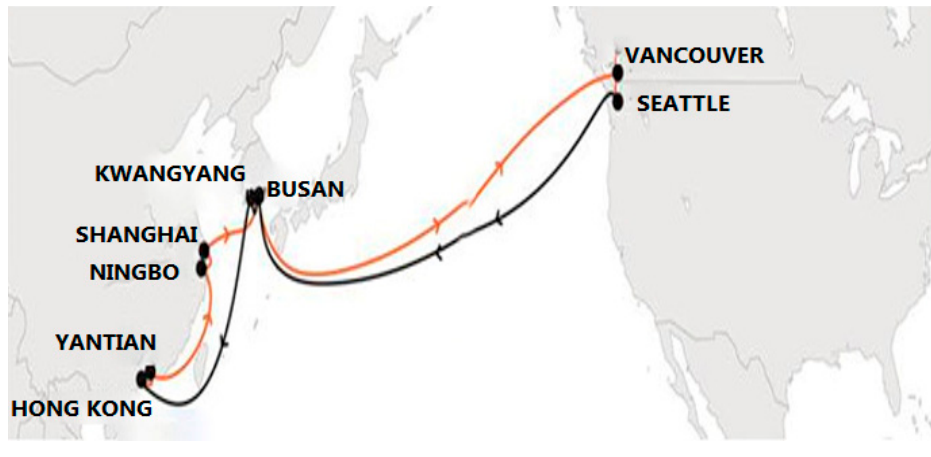
Figure 1. Schematic diagram of the ship route in this study. Table 3. Cost items of implementing Strategy very low-sulfur fuel oil (VLSFO) and Strategy Scrubber.